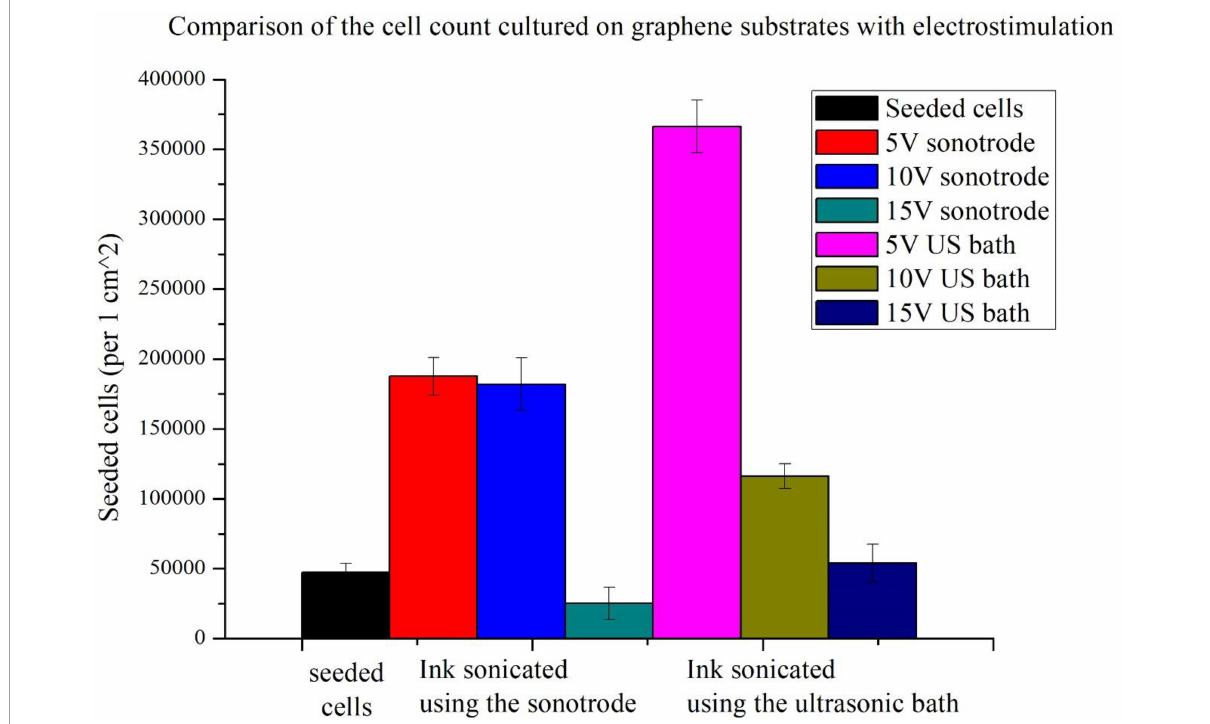
FIGURE5 Comparison of cell counts cultured on graphene substrates and stimulated using different voltage amplitudes (5, 10, and 15 V).